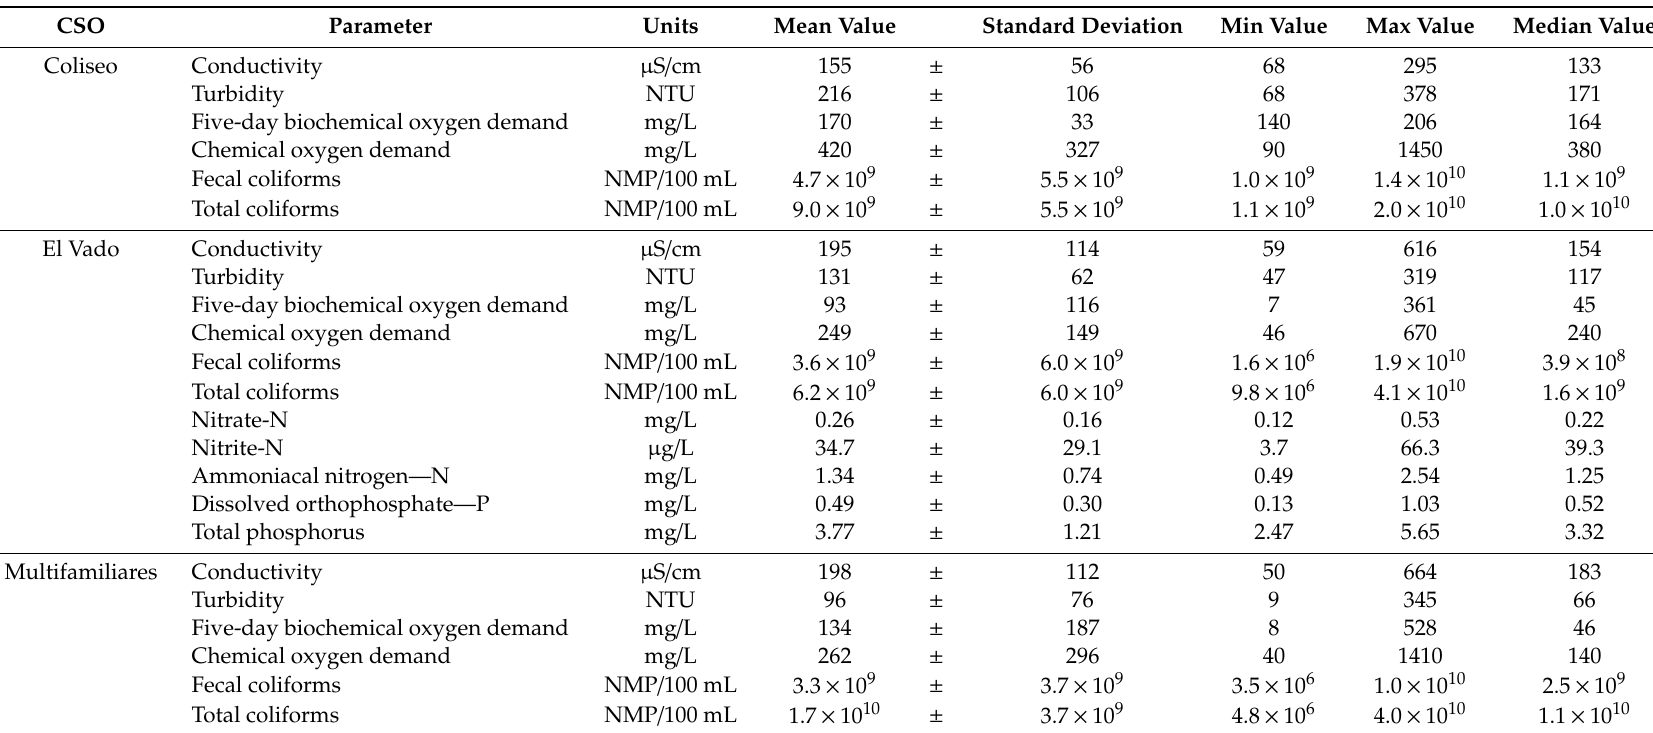
Table A1. Summary of the collected physical, chemical and microbiological data based on the registration of 18 CSO events in the Coliseo, El Vado and Multifamiliares CSOs in 2017 and